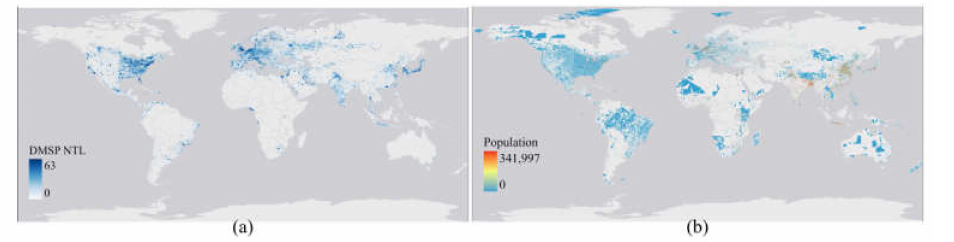
Figure 1. ( a ) Defense Meteorological Satellite Program (DMSP) nighttime light (NTL) and ( b ) Global Human Settlement Layer (GHSL) population distribution data for the year